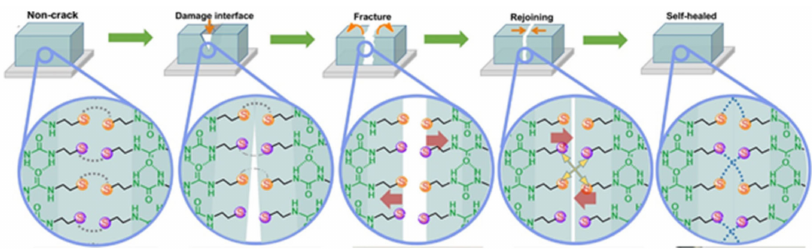
Figure 40. Schematic representation of a self-healing process with a disulfide bond and an H-bond. Reprinted with permission from [197]. Copyright (2020) American Chemical Society.